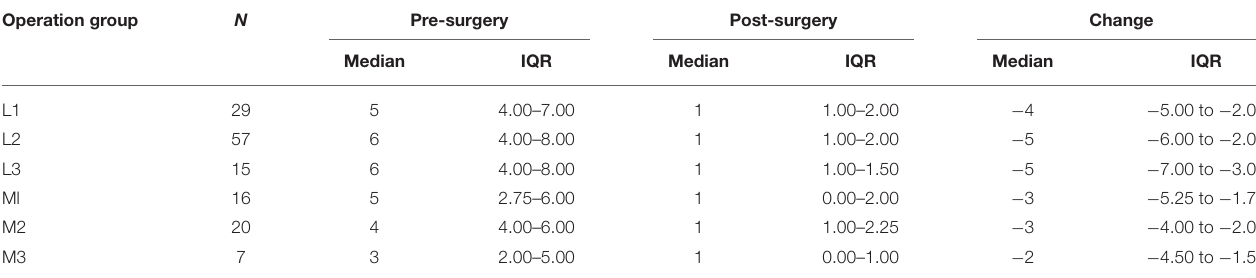
TABLE 3 | Operation group as per the EHS classification showed no difference in the pre and post-operative pain scores ( P = 0.329). Operation group N Pre-surgery Post-surgery Change